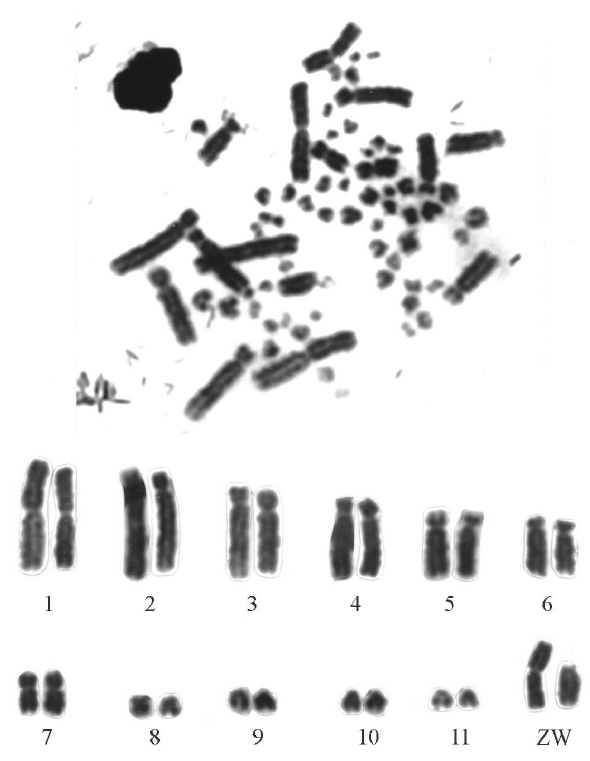
Figure 2 - Mitotic metaphase and female karyotype of Deroptyus accipitrinus